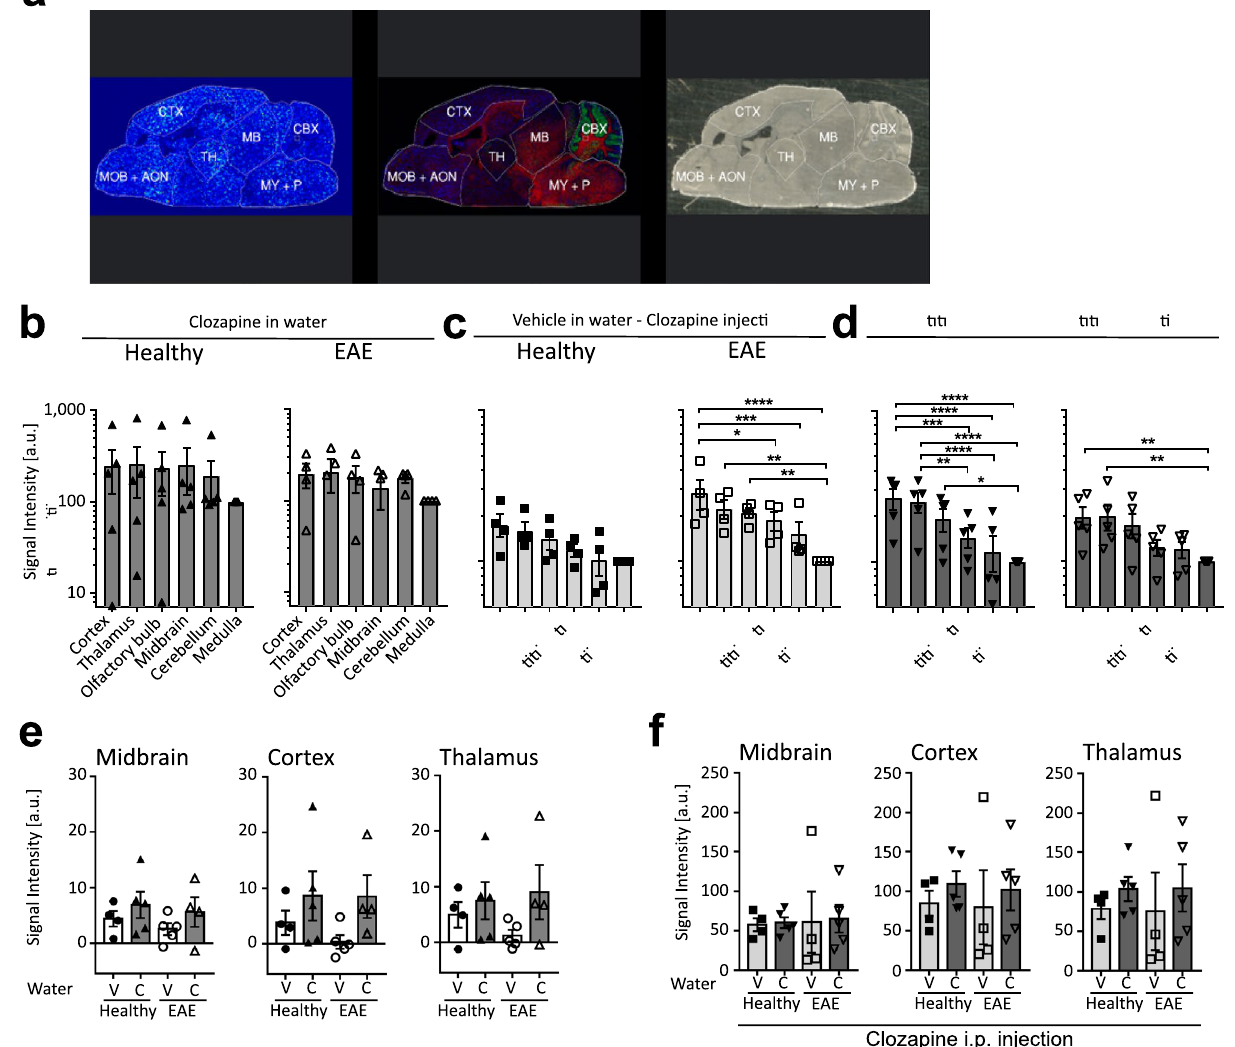
Figure 2. Segmentation of mouse brain into different brain regions and clozapine intensity . (a) Optical image, clozapine MALDI image and different lipid distributions for the segmentation into different brain regions. CBX cerebellum; CTX cortex; MB midbrain; MOB + AON main and accessory olfactory bulb; MY + P medulla and pons; TH thalamus. Clozapine intensity in the different brain region measured by MALDI in mice with clozapine in the drinking water only (b) and vehicle (c) or clozapine (d) in the drinking water and i.p. re-injection of 10 mg/kg clozapine. (n = 4–5 mice/group), two-way ANOVA repeated measure followed by Sidak’s multiple comparison test, *p > 0.05; **p > 0.01; ***p > 0.001, ****p > 0.0001 (e) Clozapine intensity in midbrain, cortex and thalamus in healthy and EAE mice (f) and after clozapine re-injection C – clozapine; V—